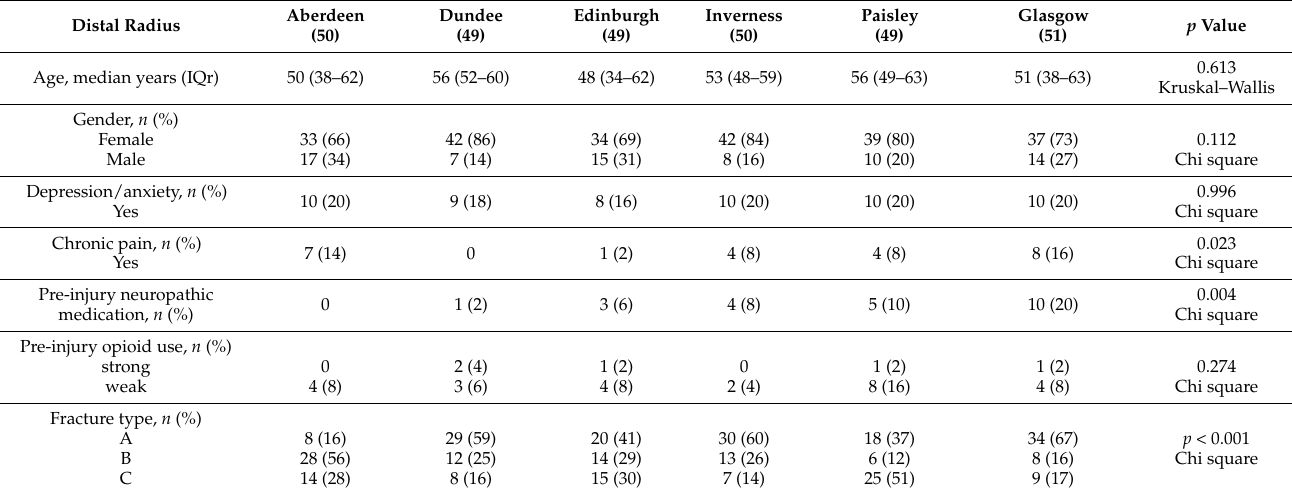
Table 1. Distal radius fracture cohort